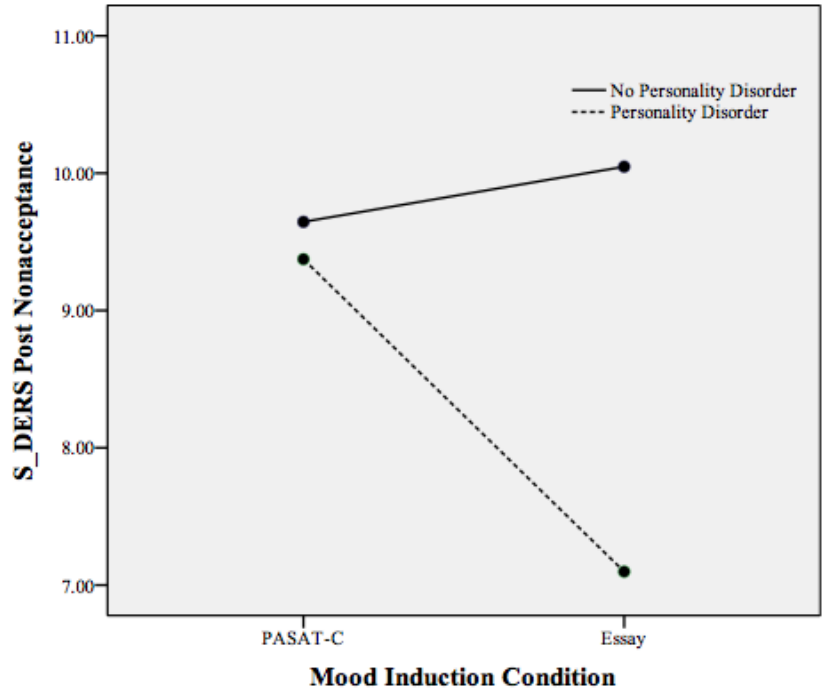
Figure 3 . Plot of the statistically significant interaction between mood induction condition and personality disorder on the S-DERS subscale of state difficulties in non-acceptance of emotions following both mood inductions. Higher scores indicate more non-acceptance of